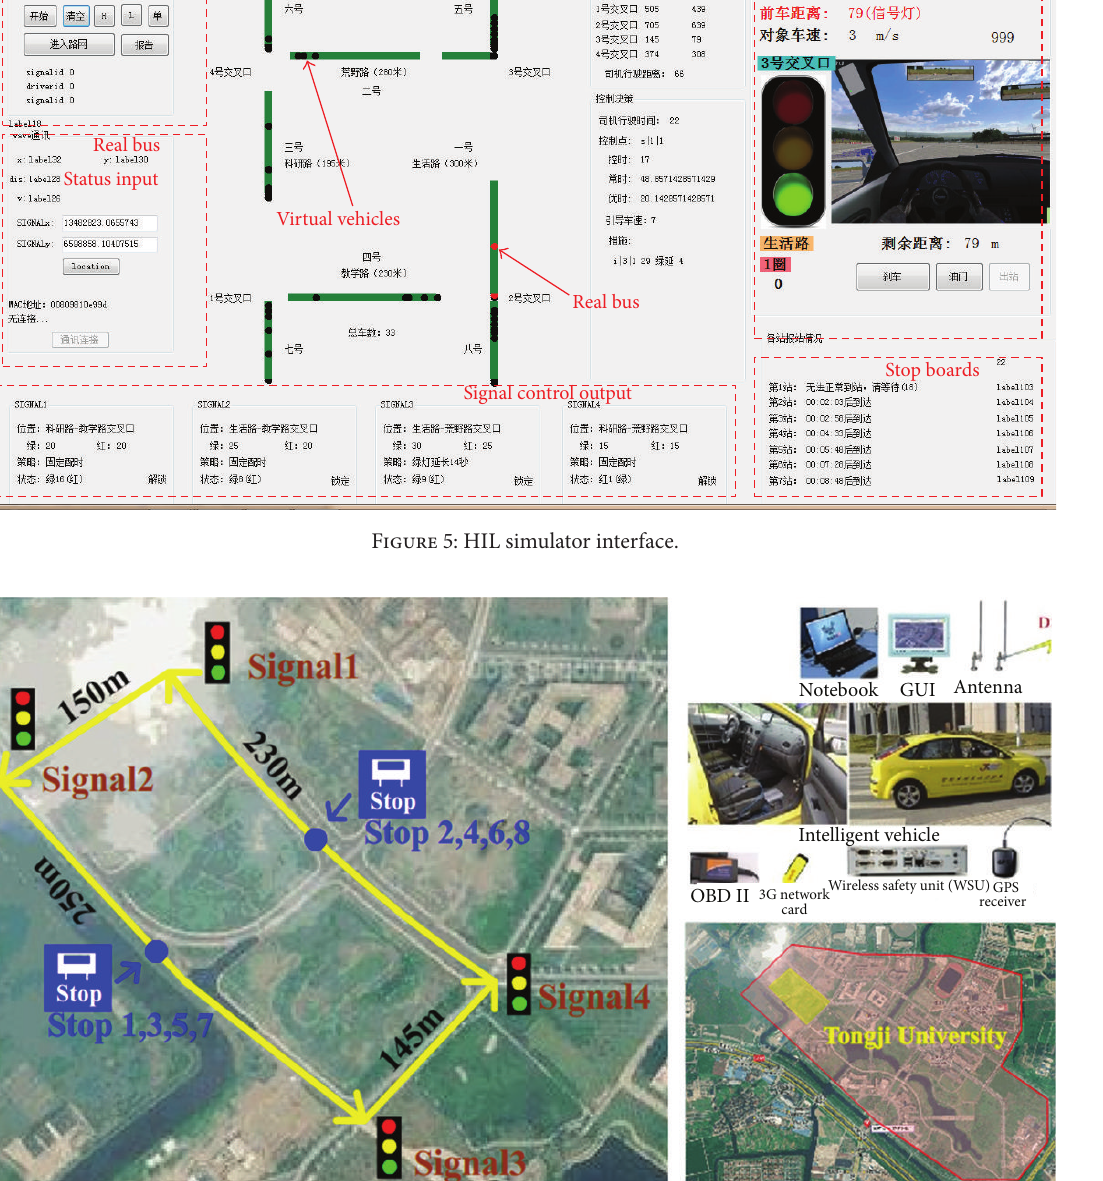
Figure 6: Field equipment and the test